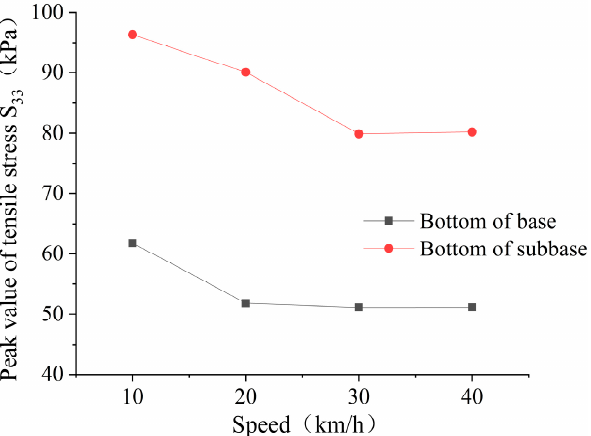
Figure 12. Variation in peak value of longitudinal tensile stress with vehicle speed.